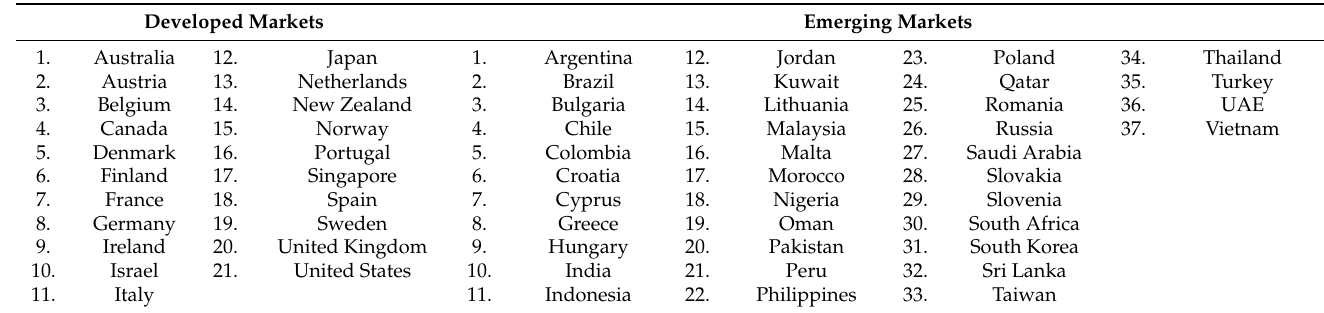
Table 1. Countries included in the